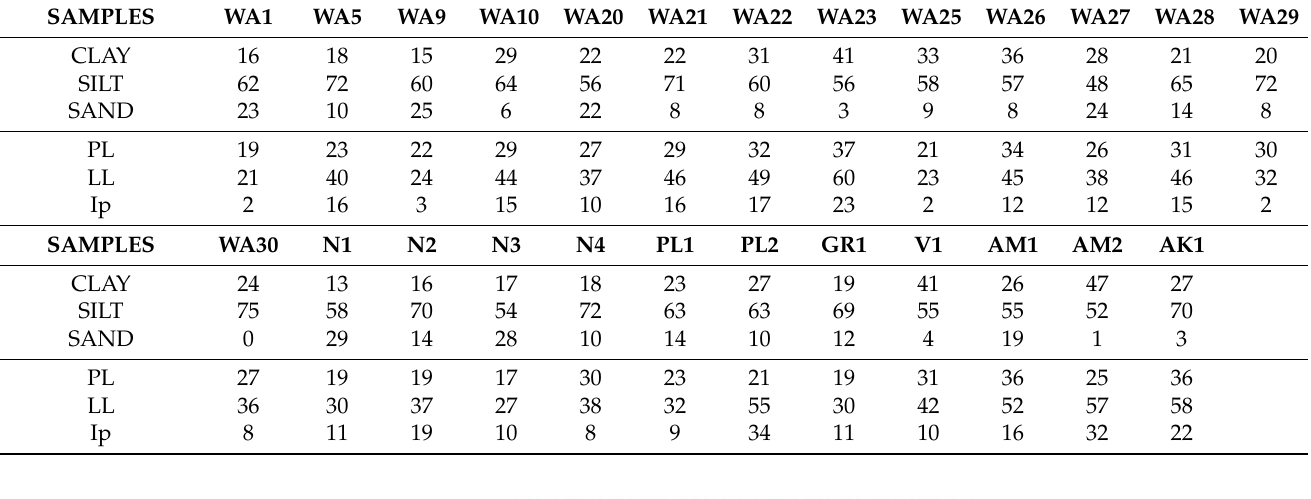
Table 3. The Atterberg limit values (in wt.%) for the samples considered in the present study. Abbreviations: LL = liquid limit; PL = plastic limit; Ip = plasticity index and the proportions of the main granulometric fractions of the studied clay-rich raw material in wt.%.